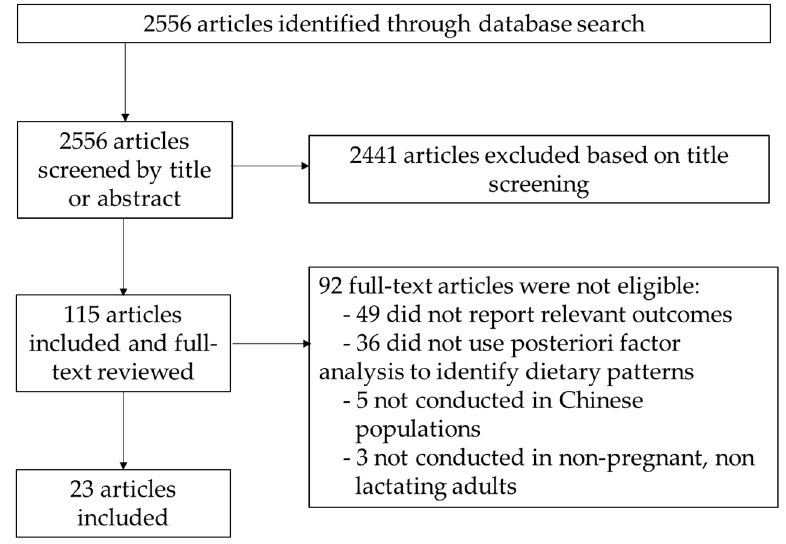
Figure 1. Flowchart for the article selection process.